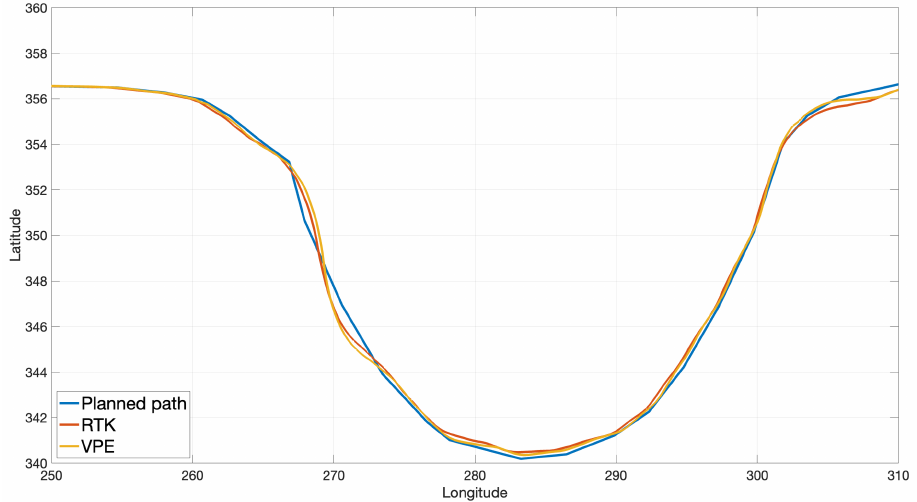
Figure 21. RTK positions and estimated